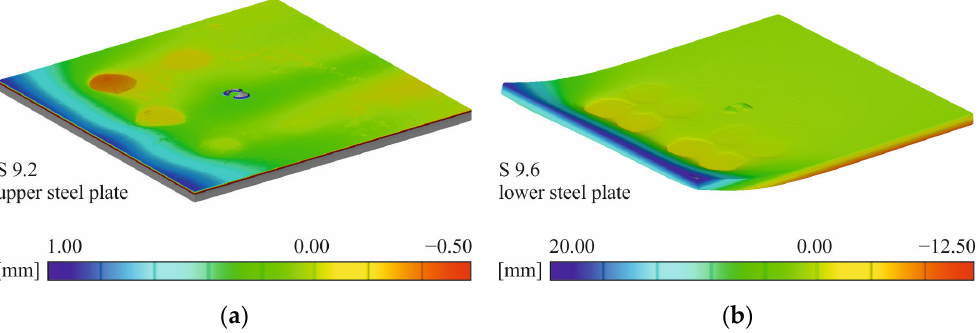
Figure 7. Three-dimensional laser scans: ( a ) upper steel plate of S 9.2; ( b ) lower steel plate of S 9.6.